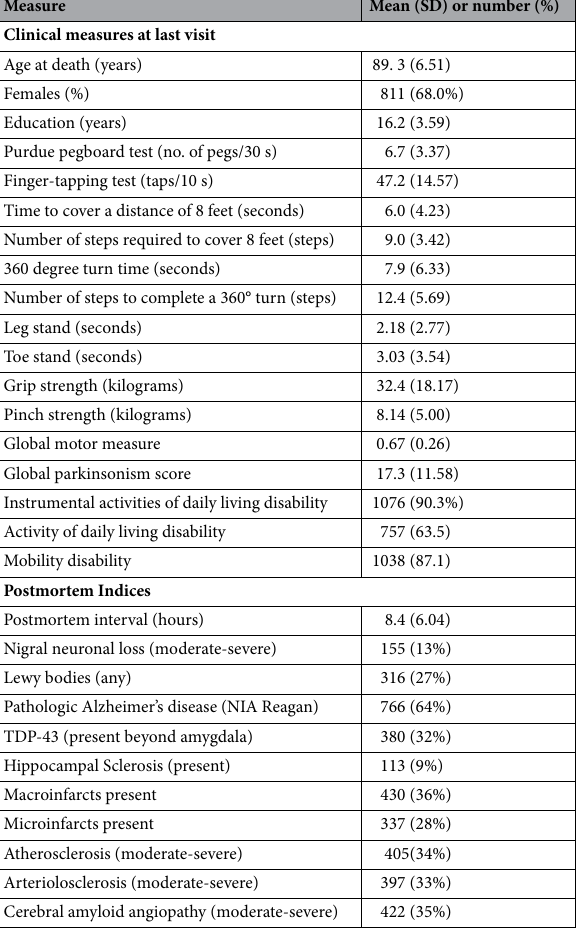
Table 1. Clinical and postmortem characteristic of the analytic